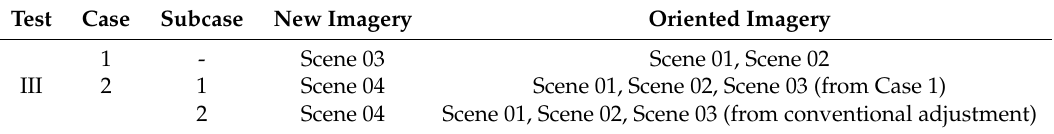
Table 7. SPOT-5 datasets for direct georeferencing with the oriented imagery.